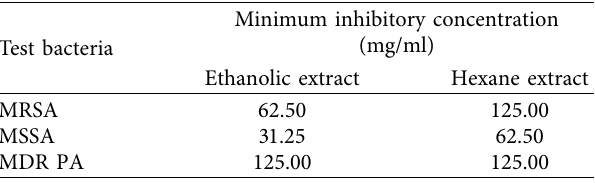
Table 4: Minimum inhibitory concentration (MIC) of the etha- nolic and hexane crude extract of A. heterophyllus seeds against selected bacteria.